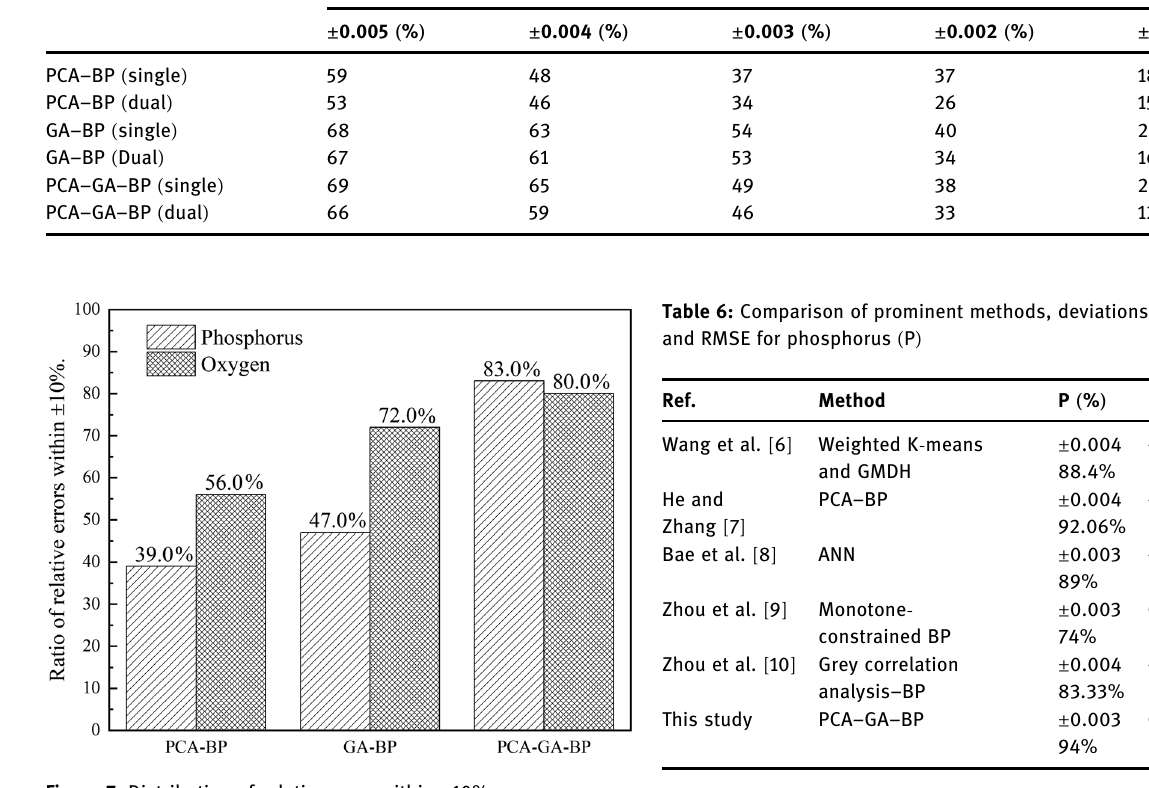
Table 4: Comparison of O content prediction accuracy of di ff erent models Model